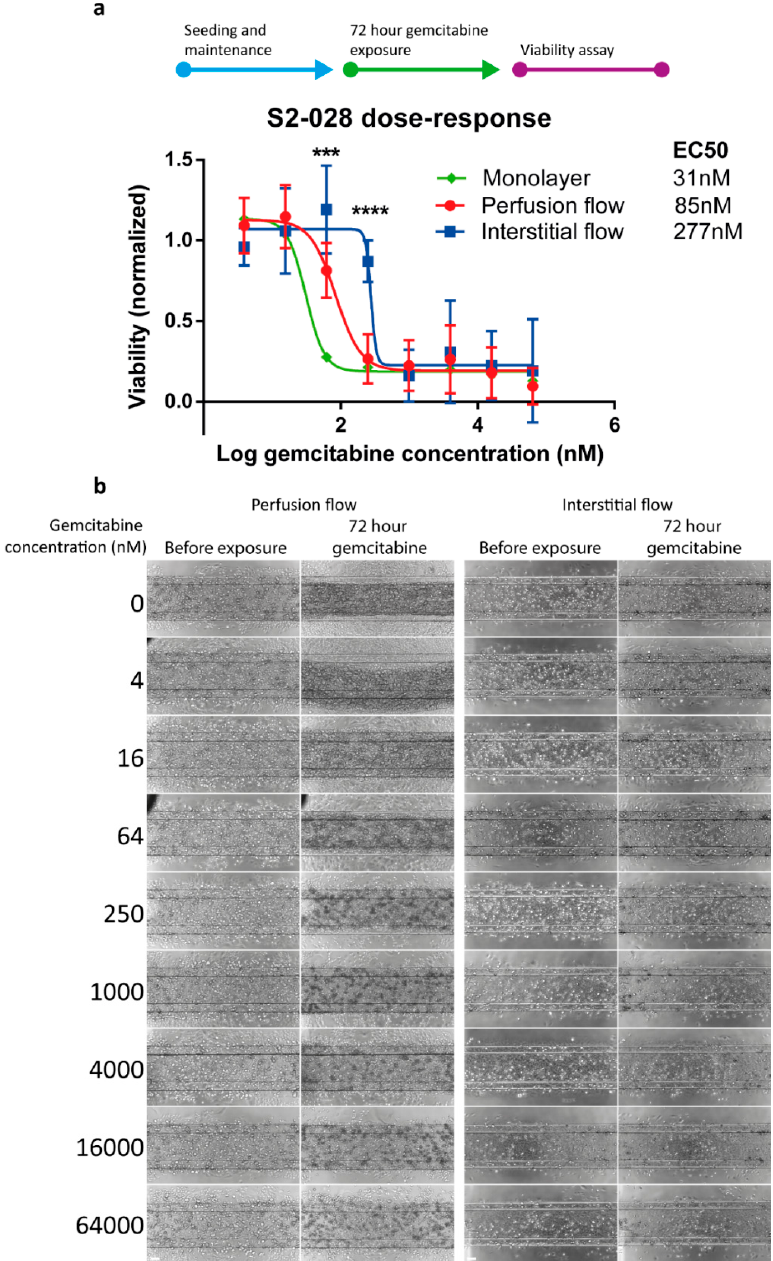
Figure 3. PDAC cells cultured with interstitial flow are less responsive to gemcitabine. S2-028